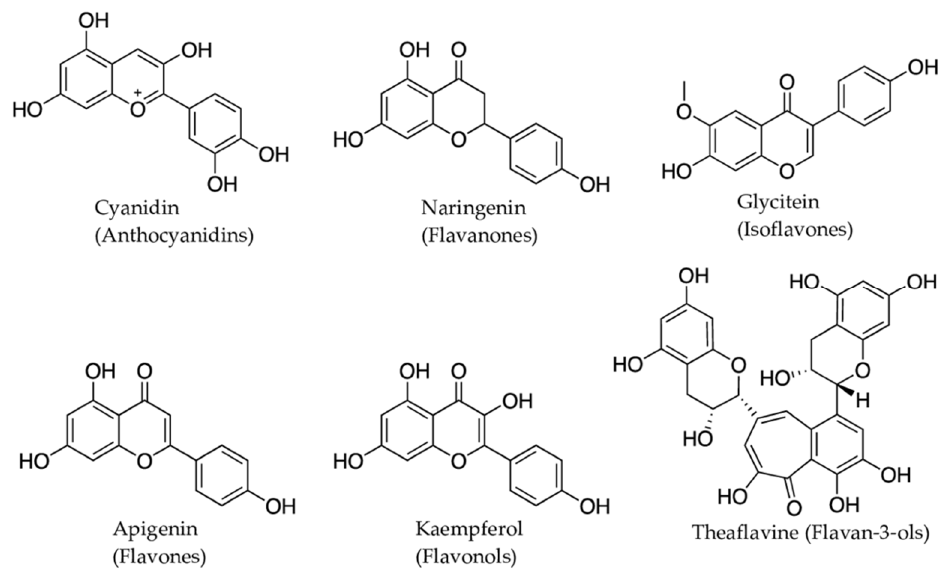
Figure 2. Representative examples of different subgroups of flavonoids: a major phenolic group of secondary metabolites.